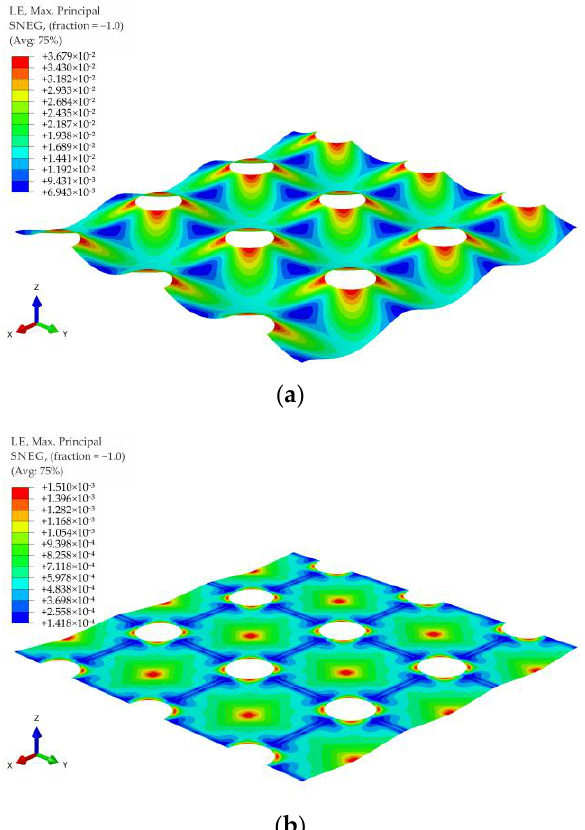
Figure 31. Deformation and maximum principal strain in reinforcement for pyramid shape load distribution, variant B1: ( a ) k = 0 kN/m 3 ; ( b ) k = 500 kN/m 3 .